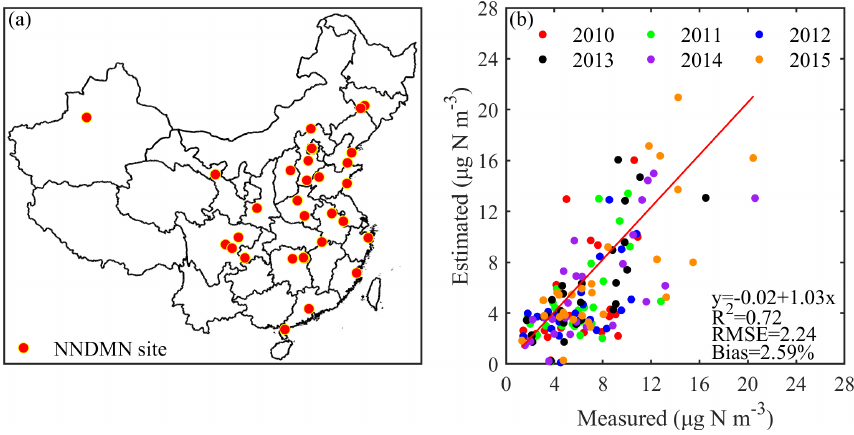
Figure 4. Comparison of IASI surface NH 3 concentrations with NNDMN measurements. (a) The locations of NNDMN; (b) the regression results between satellite estimates and